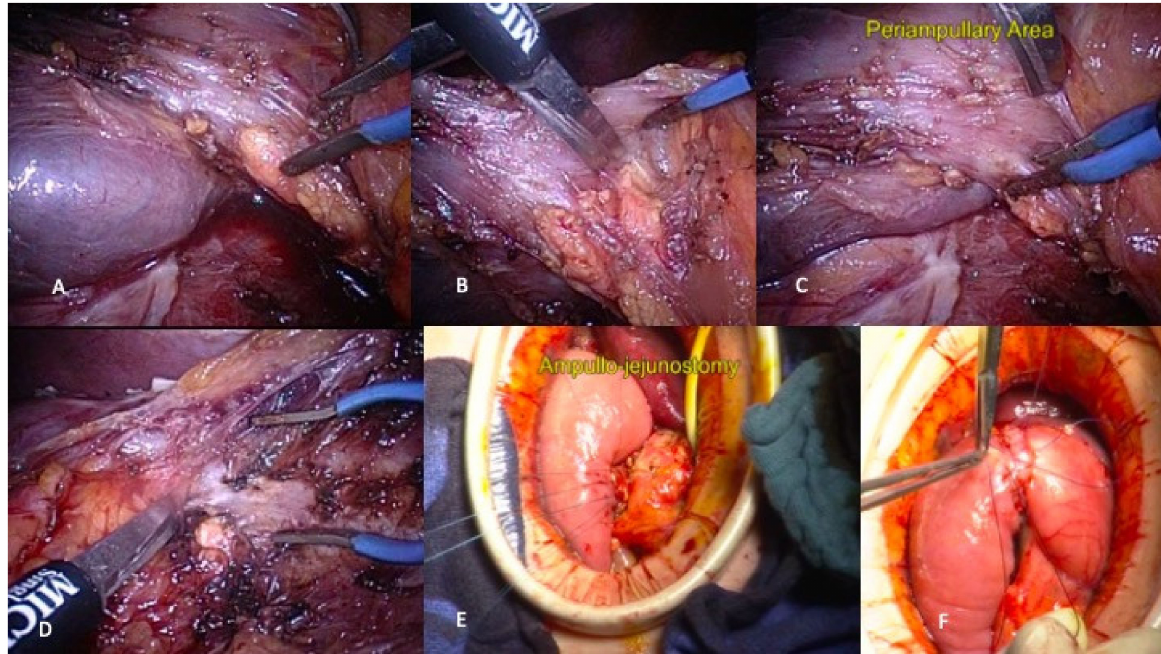
Figure 7. Laparoscopic total duodenectomy. ( A ) Kocher maneuver; ( B ) Duodenopancreatic division; ( C ) Identification of periampullary area; ( D ) Section of the ampulla; ( E ) Ampullo-jejunostomy by minilap incision; ( F ) Vision at the end of the